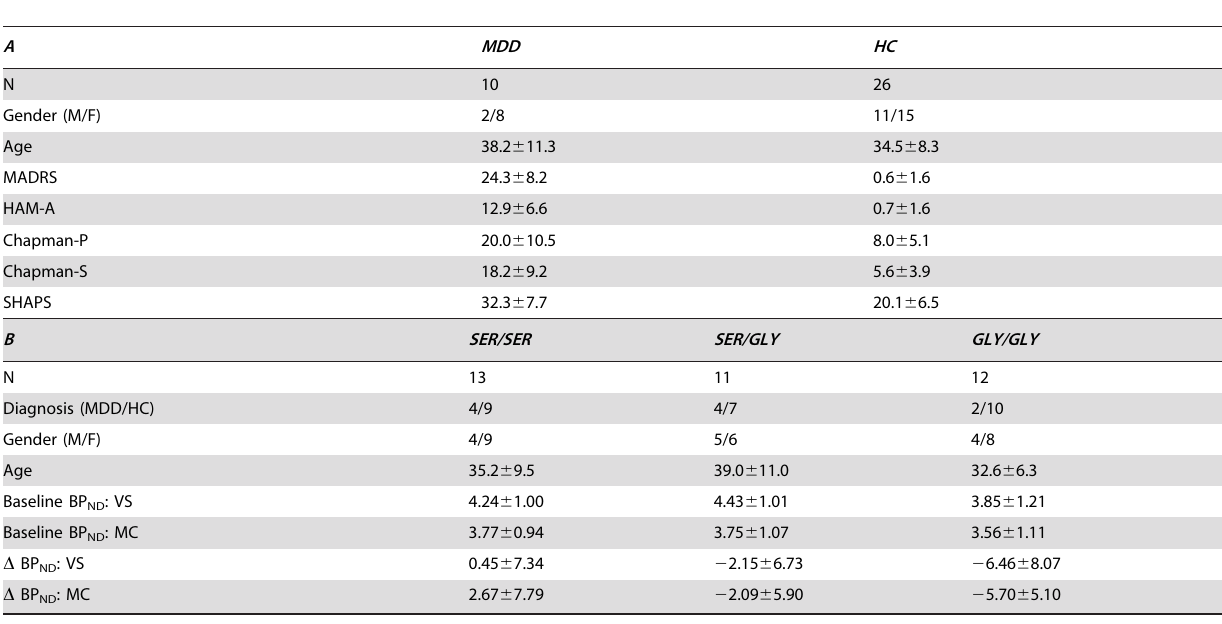
Table 1. Demographic and Clinical Data for MDD and HC Groups (A) and Total Sample Stratified by Genotype